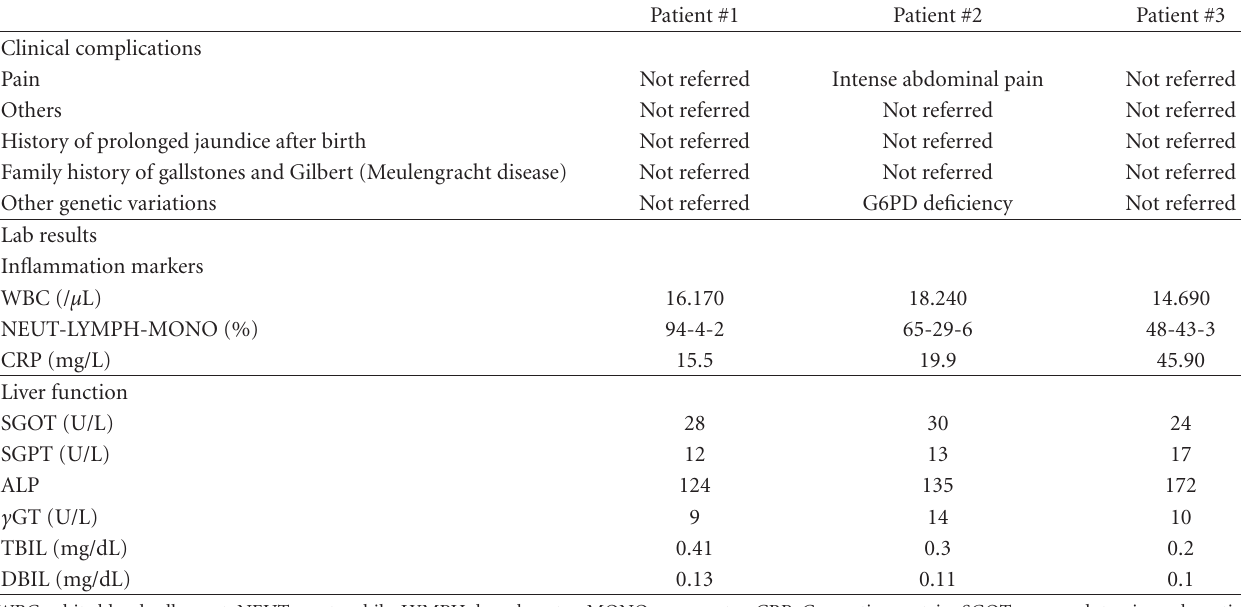
Table 1: Data about the clinical and family history and lab results (inflammation markers and liver function) of the patients.